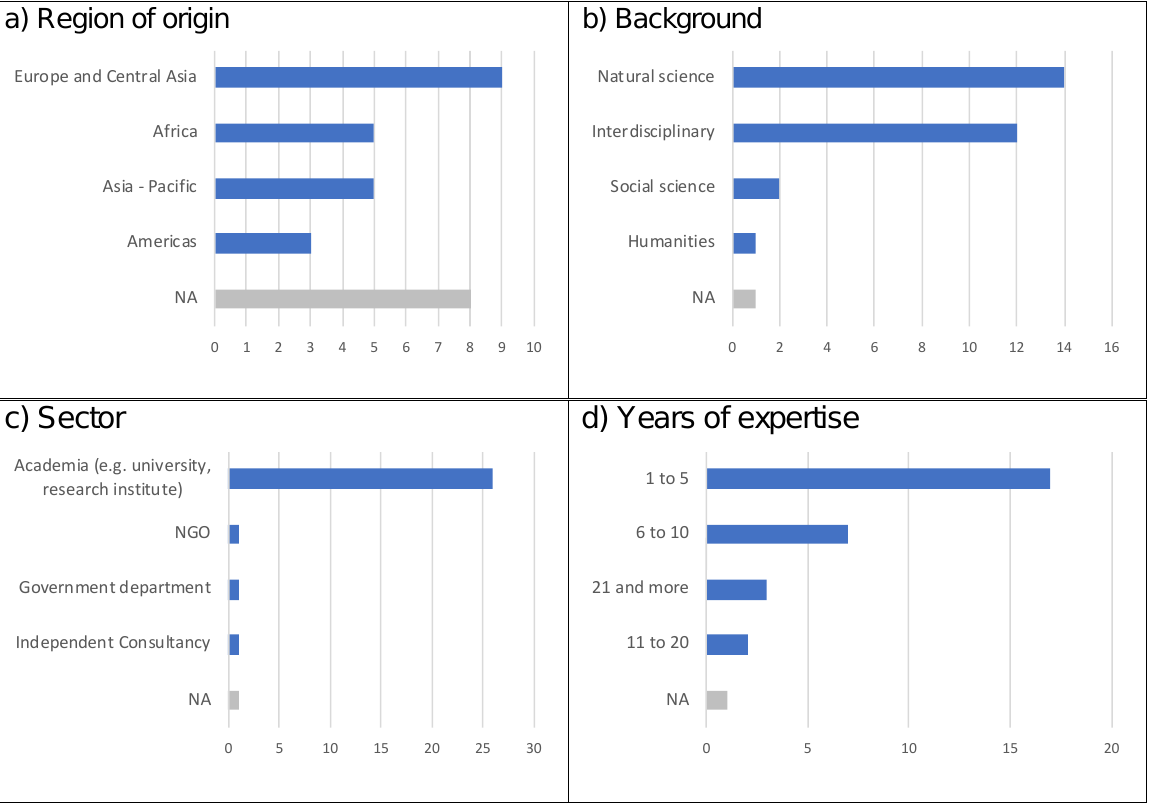
Figure A2.1: Number of respondents according to a) region of origin, b) background, c) sector, d) number of years of expertise (n =